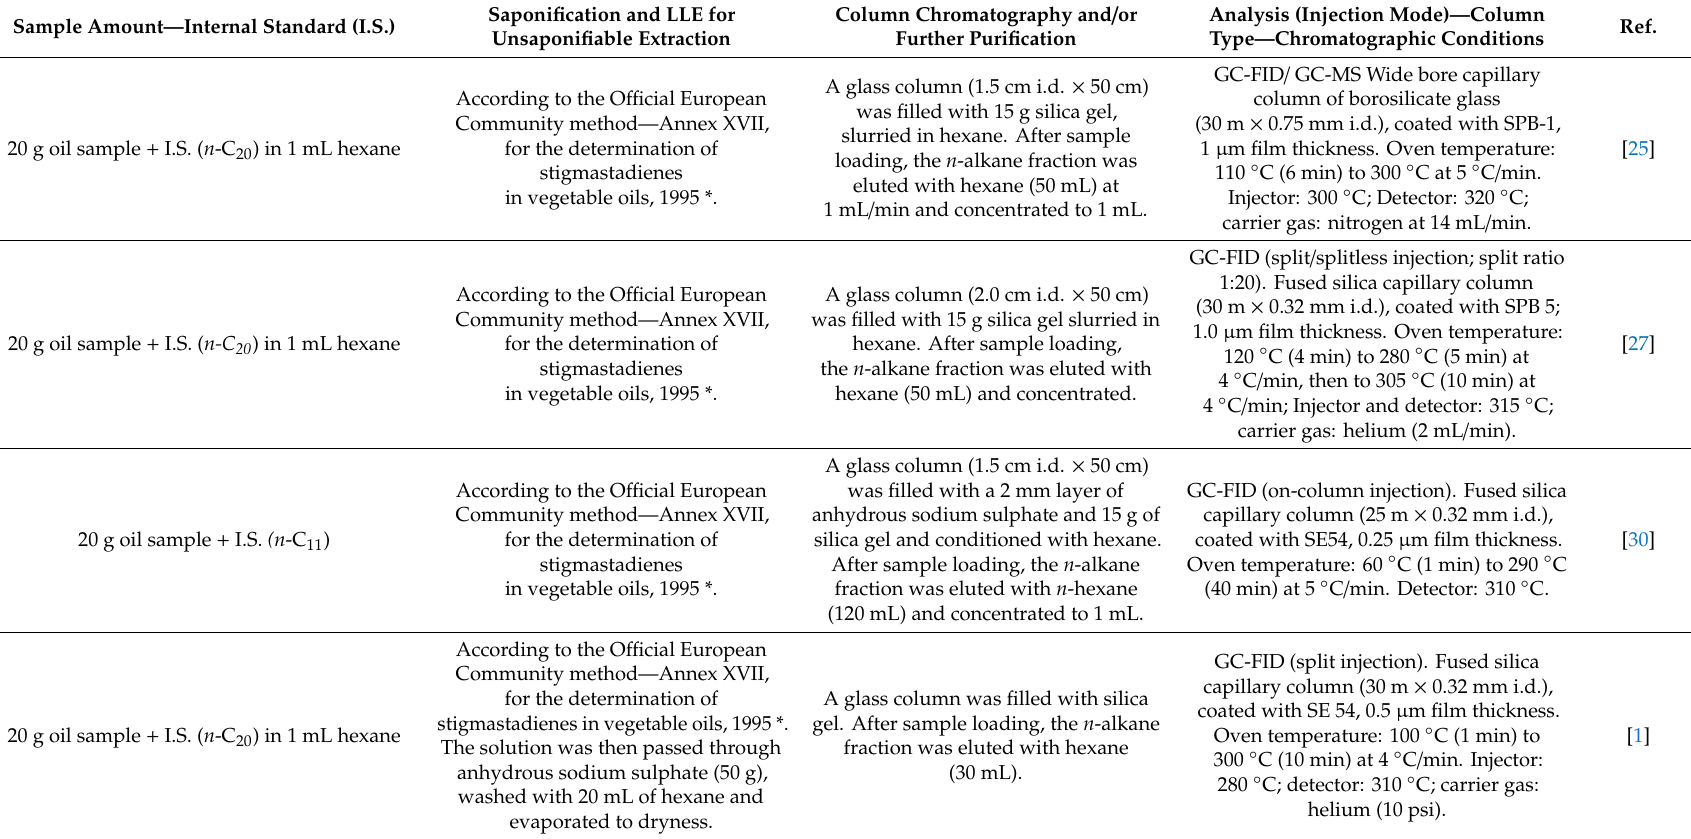
Table 3. Methods based on saponification for n-alkane determination in vegetable oils. Sample Amount—Internal Standard